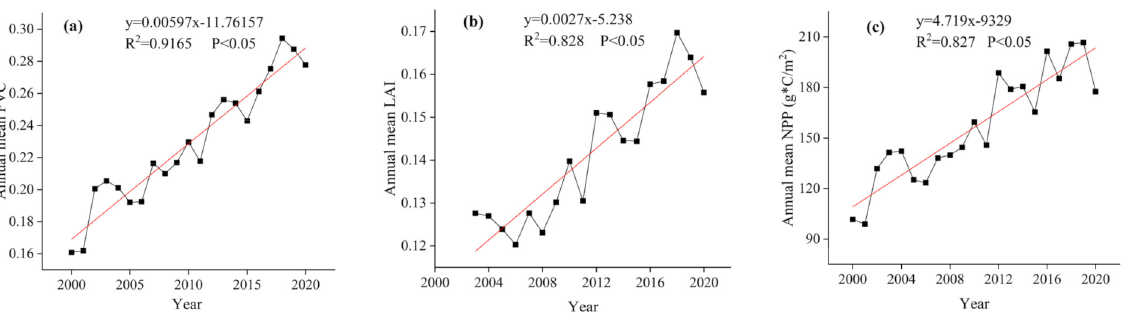
Figure 6. The FVC, LAI, and NPP over time in the Mu Us Sandy Land (( a ) is the annual mean FVC, ( b ) is the annual mean LAI, and ( c ) is the annual accumulated